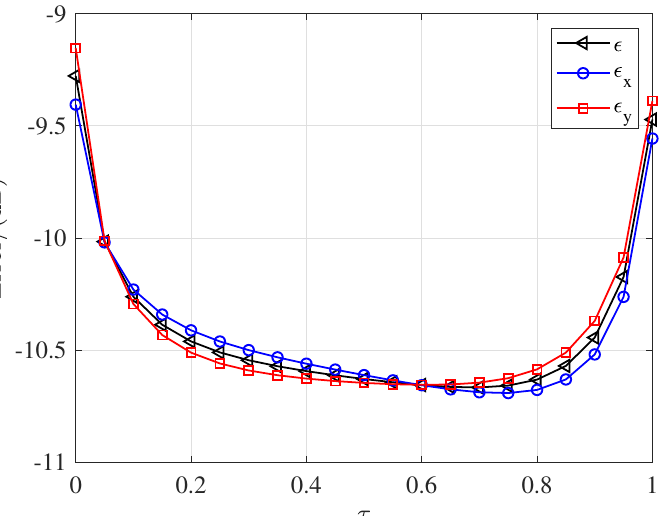
Figure 9. The NMSE of the reproduced intensity at uncontrolled points. The reverberation time RT 60 = 200 ms and the control filter length J =